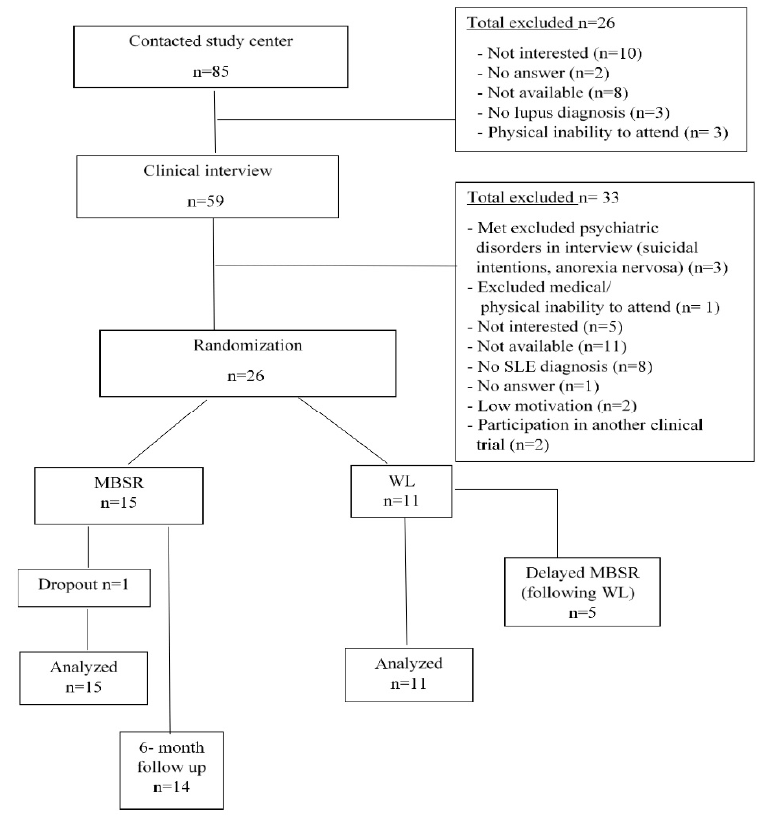
Figure 1. PRISMA flow- chart for screening and allocation process. Table 1. Baseline characteristics according to